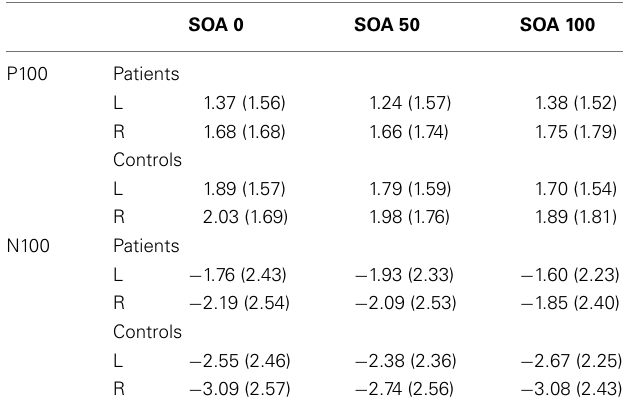
Table 2 | Mean (SD) amplitudes for each group and each ERP